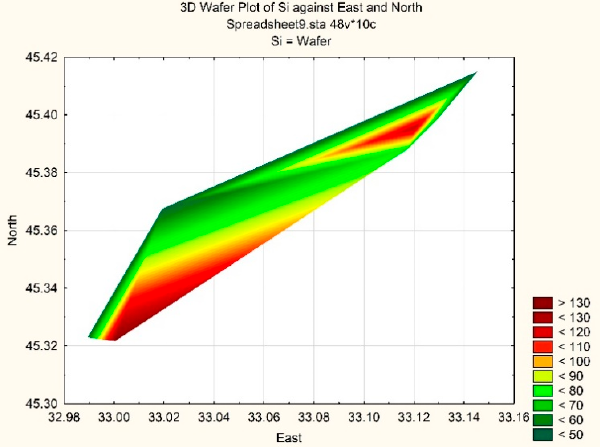
Figure 9. Dissolved organic phosphorus ( A ) and orthophosphate ( B ) concentrations in the water column at the sampling stations in the Donuzlav Gulf of the Black Sea.